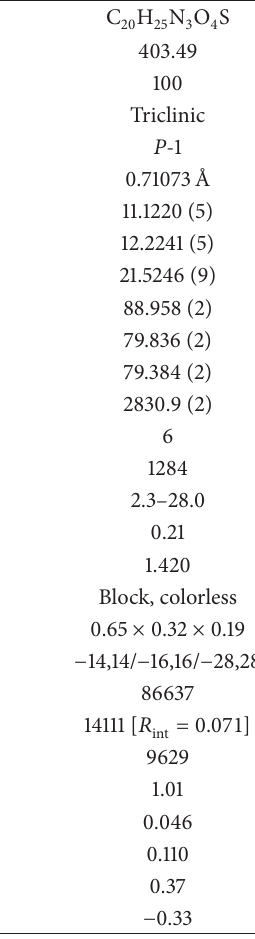
Table 1: Crystallographic data and refinement information.